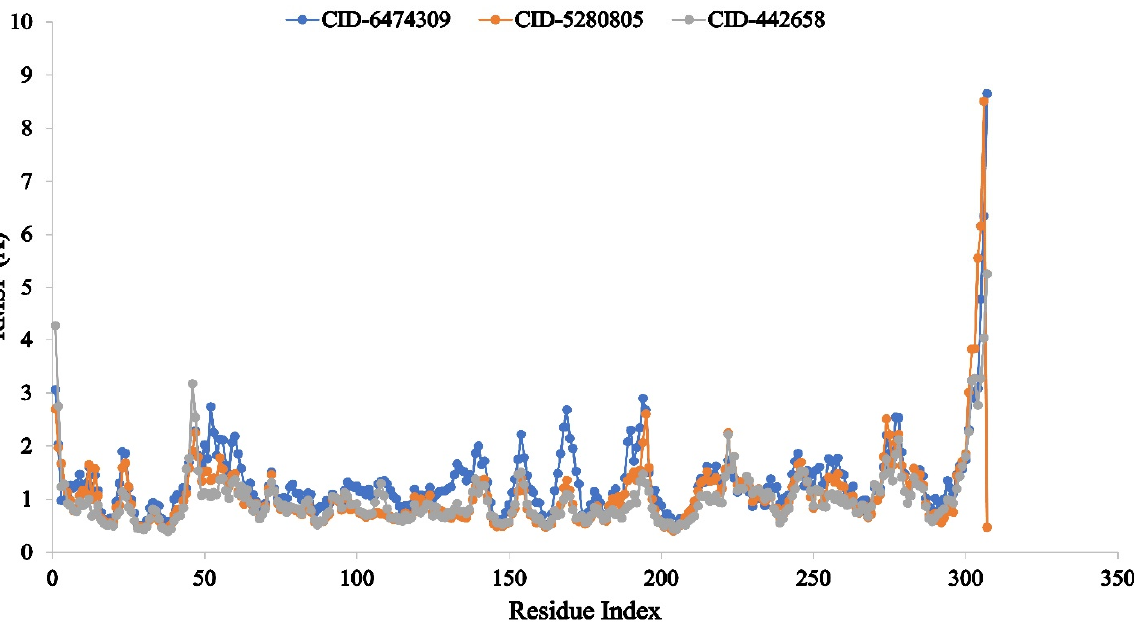
Figure 8. The RMSF values were determined for the protein C α atoms in the docked protein–ligand complexes. The selected three ligand compounds 4,5-di- O -Caffeoylquinic acid (CID-6474309), rutin